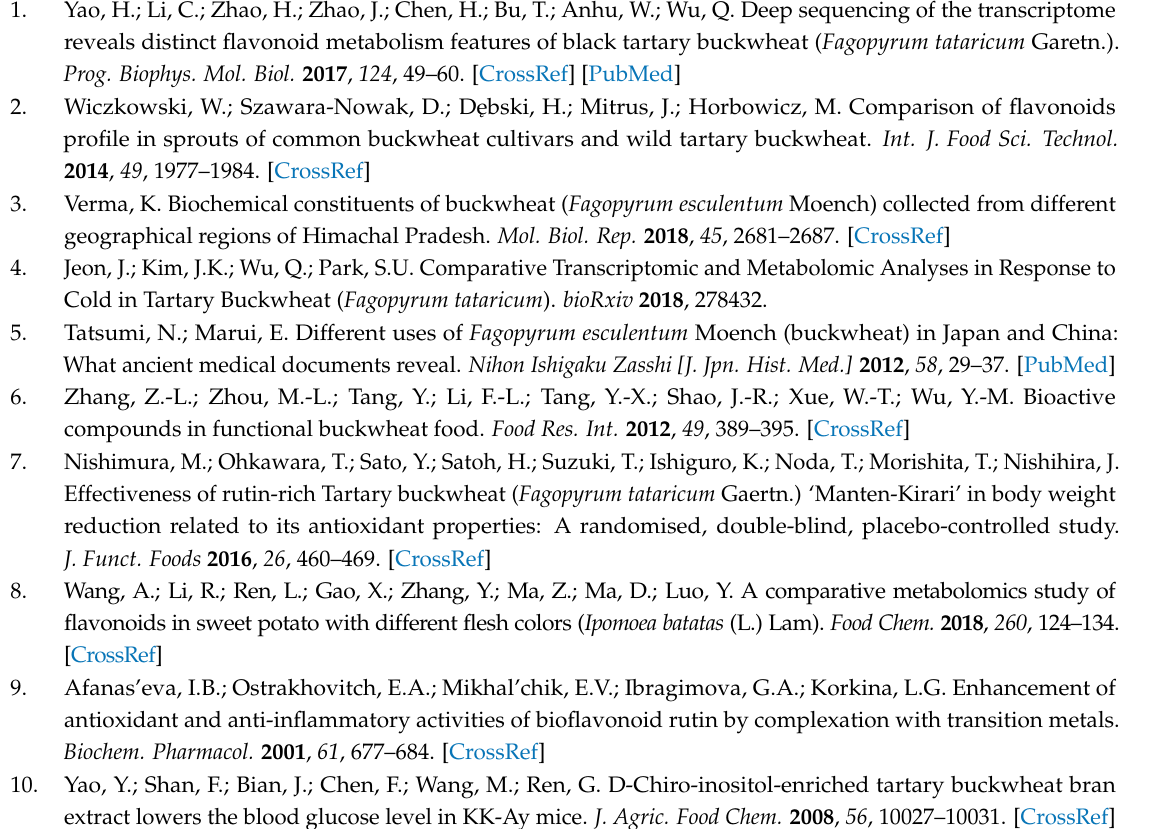
Supplementary Table S1: A list of the 182 metabolites detected in this study; Supplementary Table S2: The screening results of differential flavonoid metabolites; Supplementary Table S3: KEGG annotated results of differential flavonoid